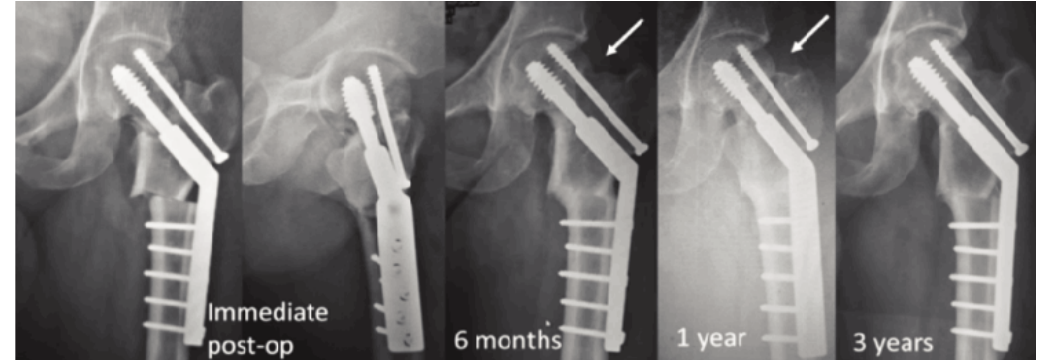
Left hip radiographs after subtrochanteric sliding osteotomy and DHS fixation. Union achieved over osteotomy site (cortical Fig. 2: bridging) at six months while femoral neck non-union site (arrow) showed progressive union at three years (fracture line disappearance).